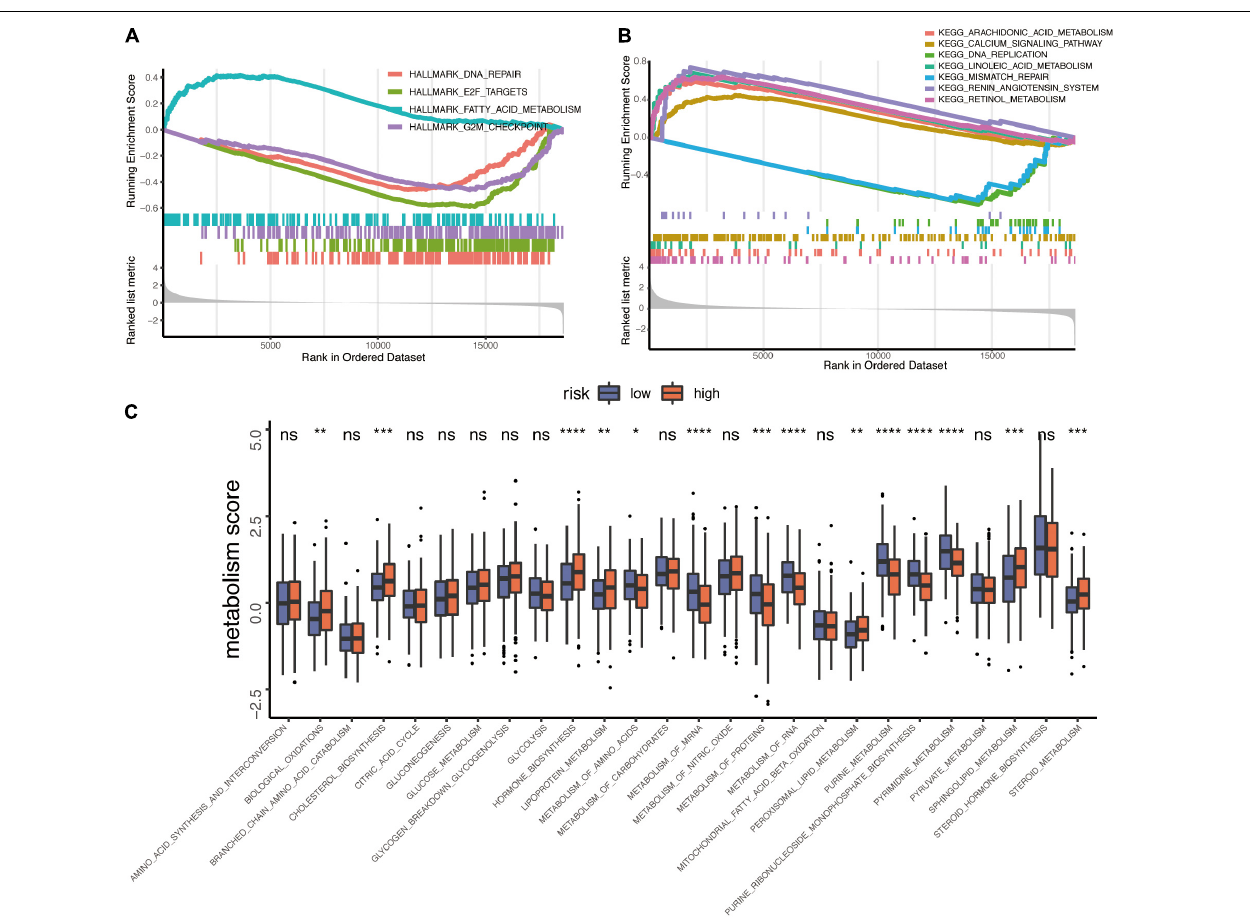
FIGURE 2 | Functional analysis of TP53INP2 in TCGA-HNSC dataset. (A,B) GSEA analysis of Hallmarks and KEGG pathway gene sets in TP53INP2-high vs. TP53INP2-low. (C) Box plot of 26 metabolism pathways between TP53INP2-high and